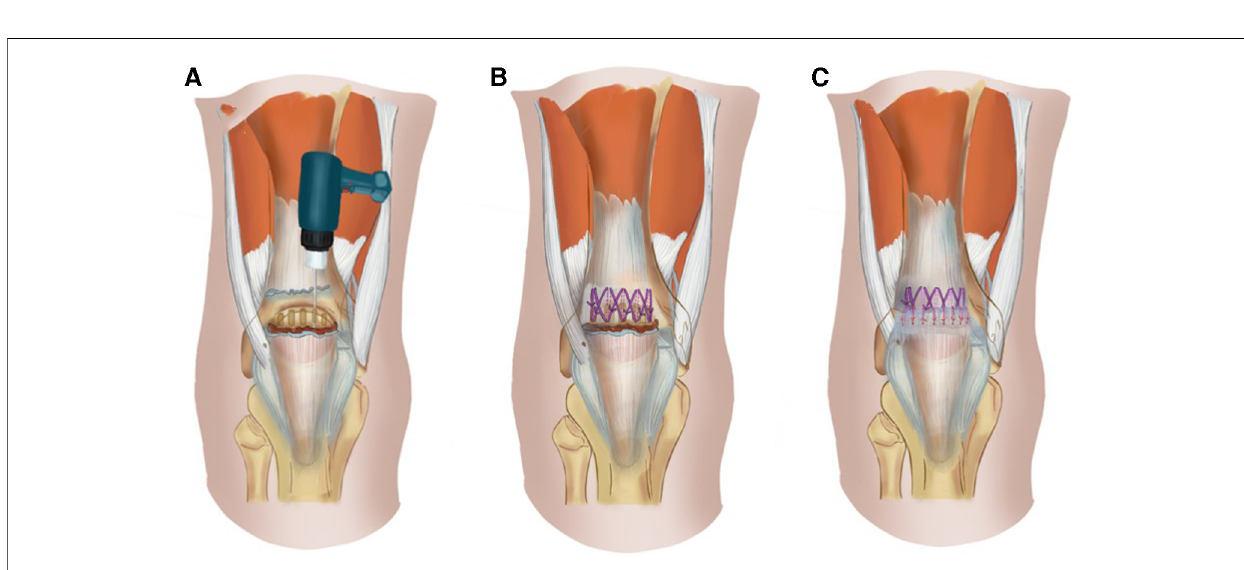
FIGURE 1 Diagram of the QT repair surgery. ( A ). Five parallel longitudinal trans-osseous tunnels with diameters of 2.0 mm were made in the upper pole of the patella using a drill. ( B ). A fi gure-of-eight suture was performed through each of the adjacent bone tunnels and simple trans-osseous sutures were achieved through the bone tunnels on both sides. ( C ). Tears in the retinaculum and deep fascia on the surface of the patella were repaired using an overlapping tightening suture with absorbable suture